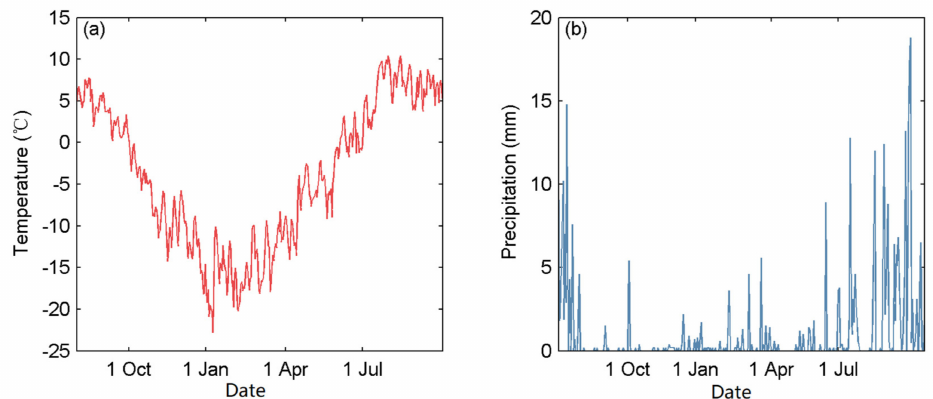
Figure 3. Daily mean temperature ( a ) and precipitation ( b ) records at the AWS from 1 August 2015 to 25 August